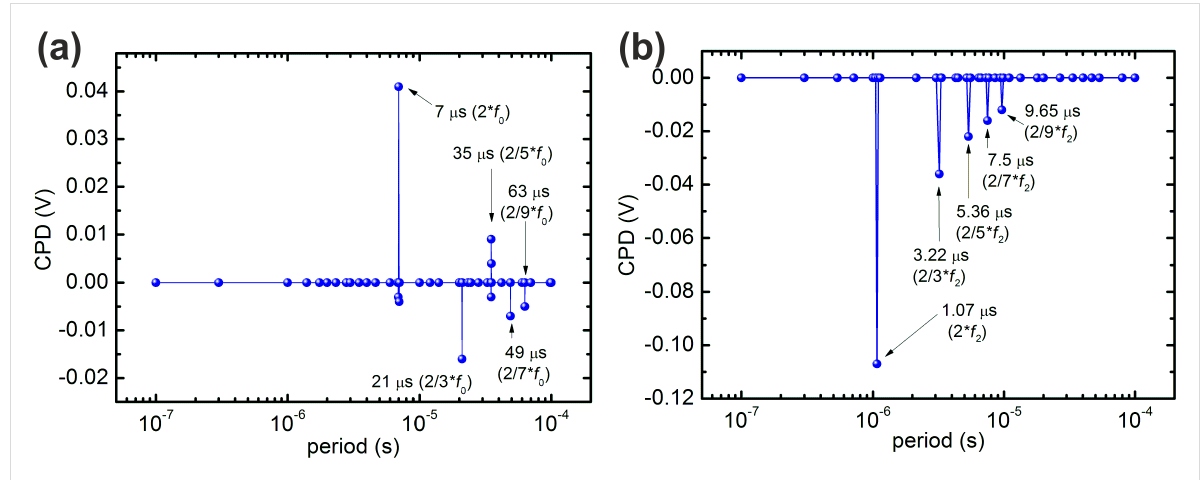
Figure 2: Frequency spectra for square pulse perturbation signal ( V pulse = 0.5 V, w pulse = ½ period) with the detection ac frequency on the (a) funda- mental cantilever eigenmode ( f ac = f 0 = 71.429 kHz) and (b) second cantilever eigenmode ( f 0 = 74.626 kHz, f ac = f 2 = 466.4125 kHz). In both cases V ac = 0.5 V was used, along with a dc bias of − 250